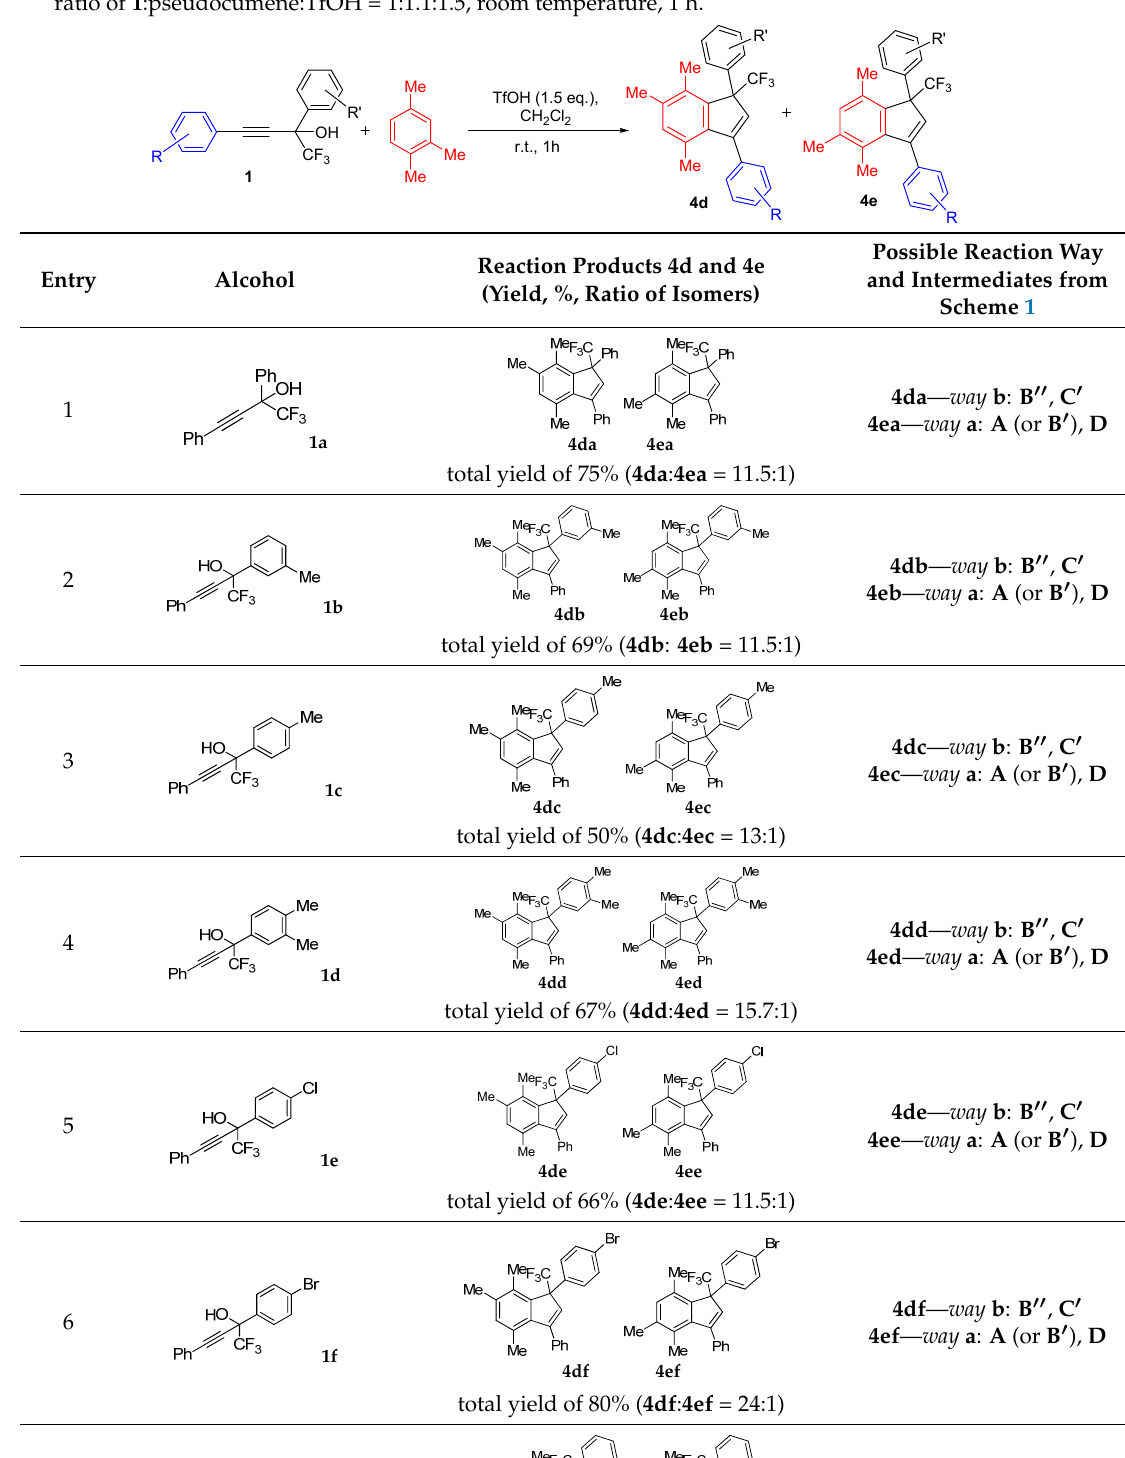
Table 6. TfOH-promoted reaction of 1 with pseudocumene; reaction conditions: TfOH, CH 2 Cl 2 , molar Molecules 2018 , 23 , x ratio of 1 :pseudocumene:TfOH = 1:1.1:1.5, room temperature, 1 h.